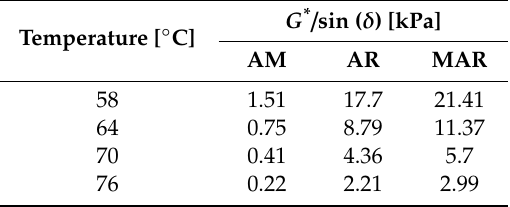
Table 5. G * / sin ( δ ) of AM, AR, and MAR.